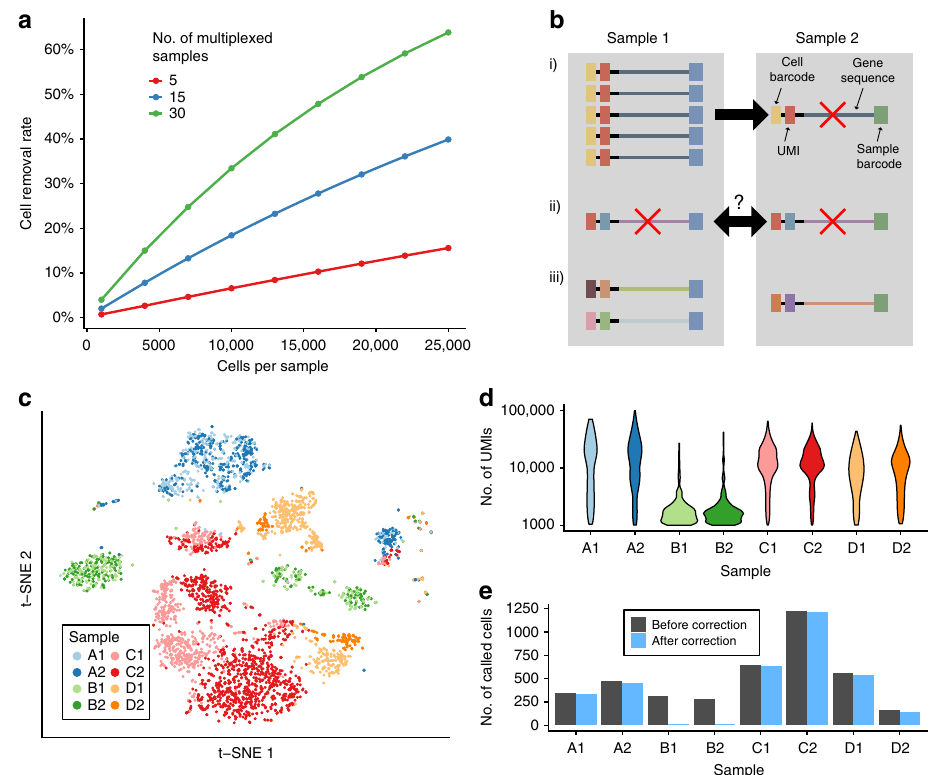
Fig. 3 Characterization of barcode swapping in droplet-based scRNA-seq experiments. a The expected number of cells with shared cell barcodes in 10x Genomics samples that have been multiplexed for sequencing, for different numbers of samples and different numbers of captured cells per sample. The cell exclusion approach for barcode swapping would remove these cells. b A schematic of our method to remove swapped reads from droplet data. Reads found in different samples with the same combination of UMI, cell barcode, and aligned gene were considered to have swapped. If most reads ( ≥ 80%) were present in one sample, we excluded the molecule from all other samples (i). If reads were more evenly spread across samples, we excluded the molecule from all samples (ii). Reads in one sample only were retained (iii). c t -SNE plot of the expression pro fi les of mouse epithelial cells 17 . Each point represents a cell that is coloured by sample. Letters correspond to different experimental conditions while numbers represent biological replicates. d The distribution of the library sizes for called cells in each sample. Cells were called using emptyDrops, with an FDR threshold of 1% and a minimum of 1000 UMIs. e The number of called cells for each sample, before and after application of our